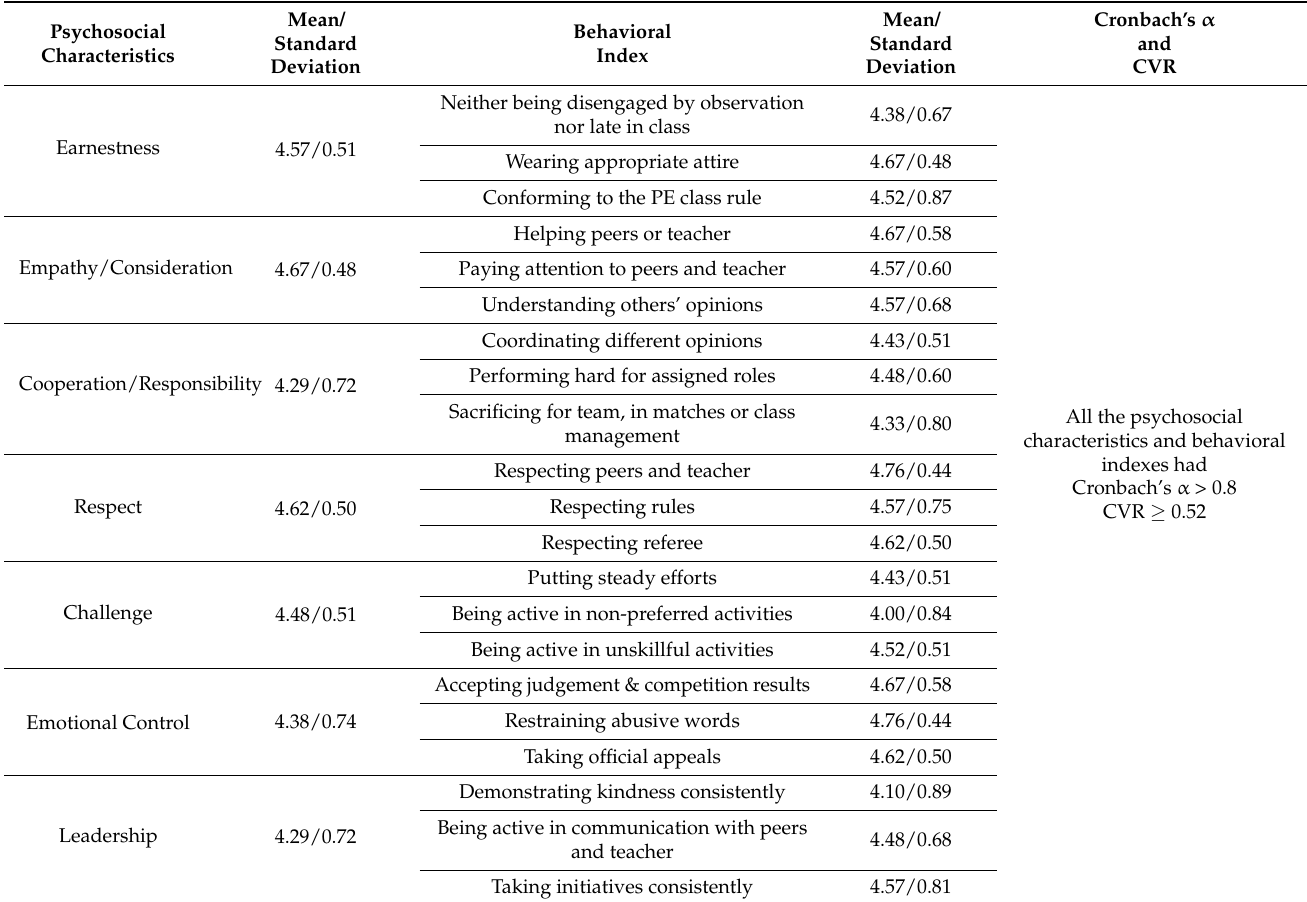
Table 4. The Psychosocial Characteristics and the Behavioral Indexes after Modified Delphi.